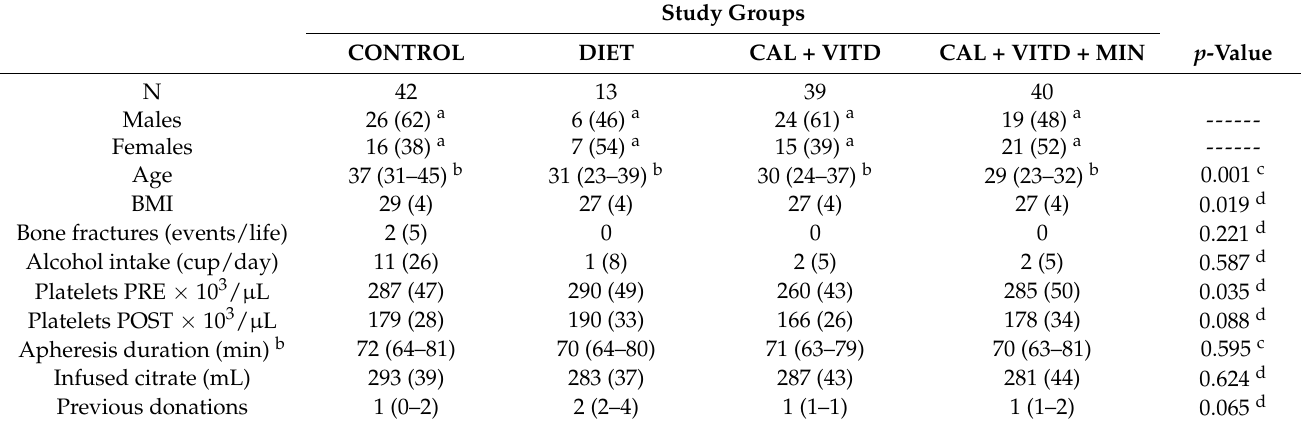
Table 1. General characteristics of donors by study group.